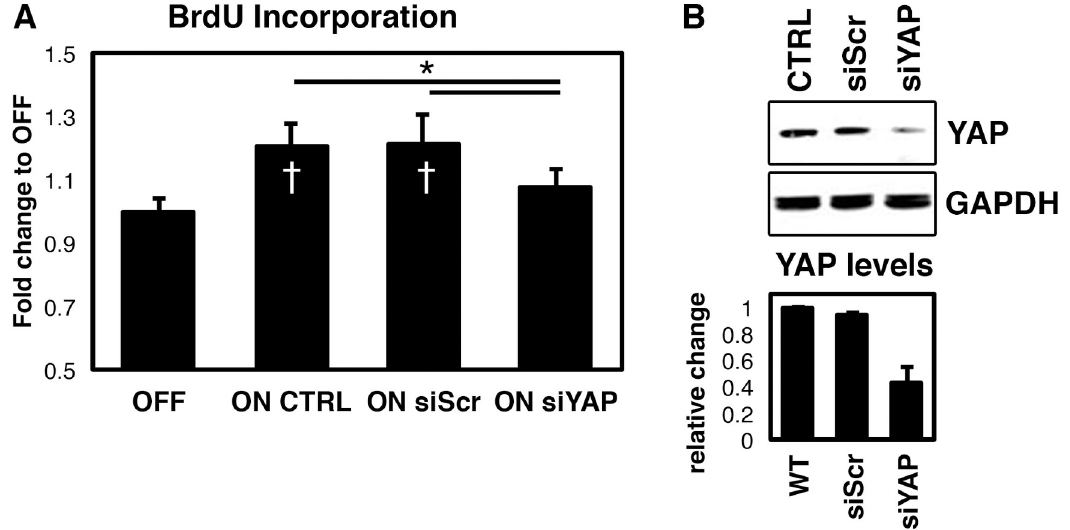
Fig 1. FLIPUS enhances cell proliferation in a YAP-dependent manner. A: BrdU incorporation in non-sonicated (OFF), FLIPUS-treated (ON CTRL), FLIPUS-treated scrambled siRNA transfected (ON siScr) and YAP-targeting siRNA transfected (ON siYAP) C2C12 cells. Each experiment was repeated four times in duplicate. B: Representative picture of western blot analysis confirming efficient YAP knockdown on protein levels with near-infrared fluorescent intensity quantification of four biological replicates Data are presented as mean ± SD � p < 0.05 indicate changes between the sonicated groups † p < 0.05 indicate changes between FLIPUS-treated and non-sonicated cells for a selected treatment.